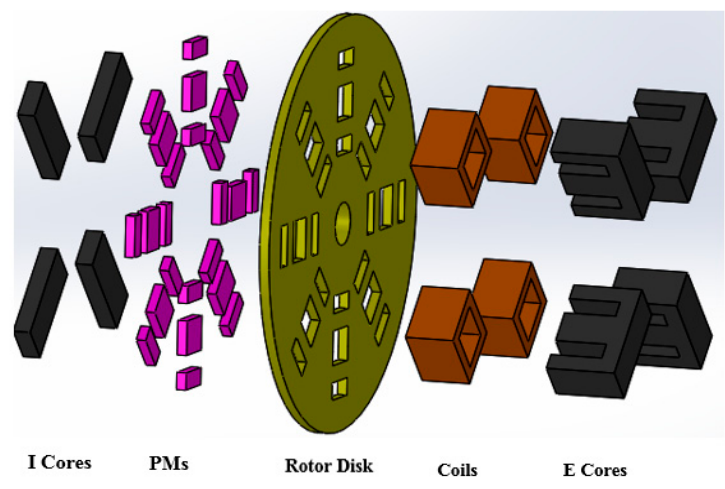
Figure 1. The scheme of transverse flux permanent magnet disk-rotor generator with E and I core (TFPMDEIG) (8 poles).